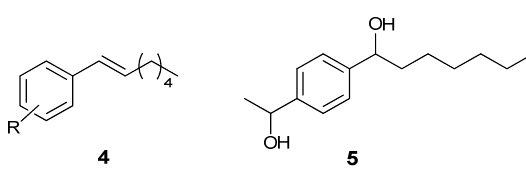
Figure 1. By ‐ products of the reaction.